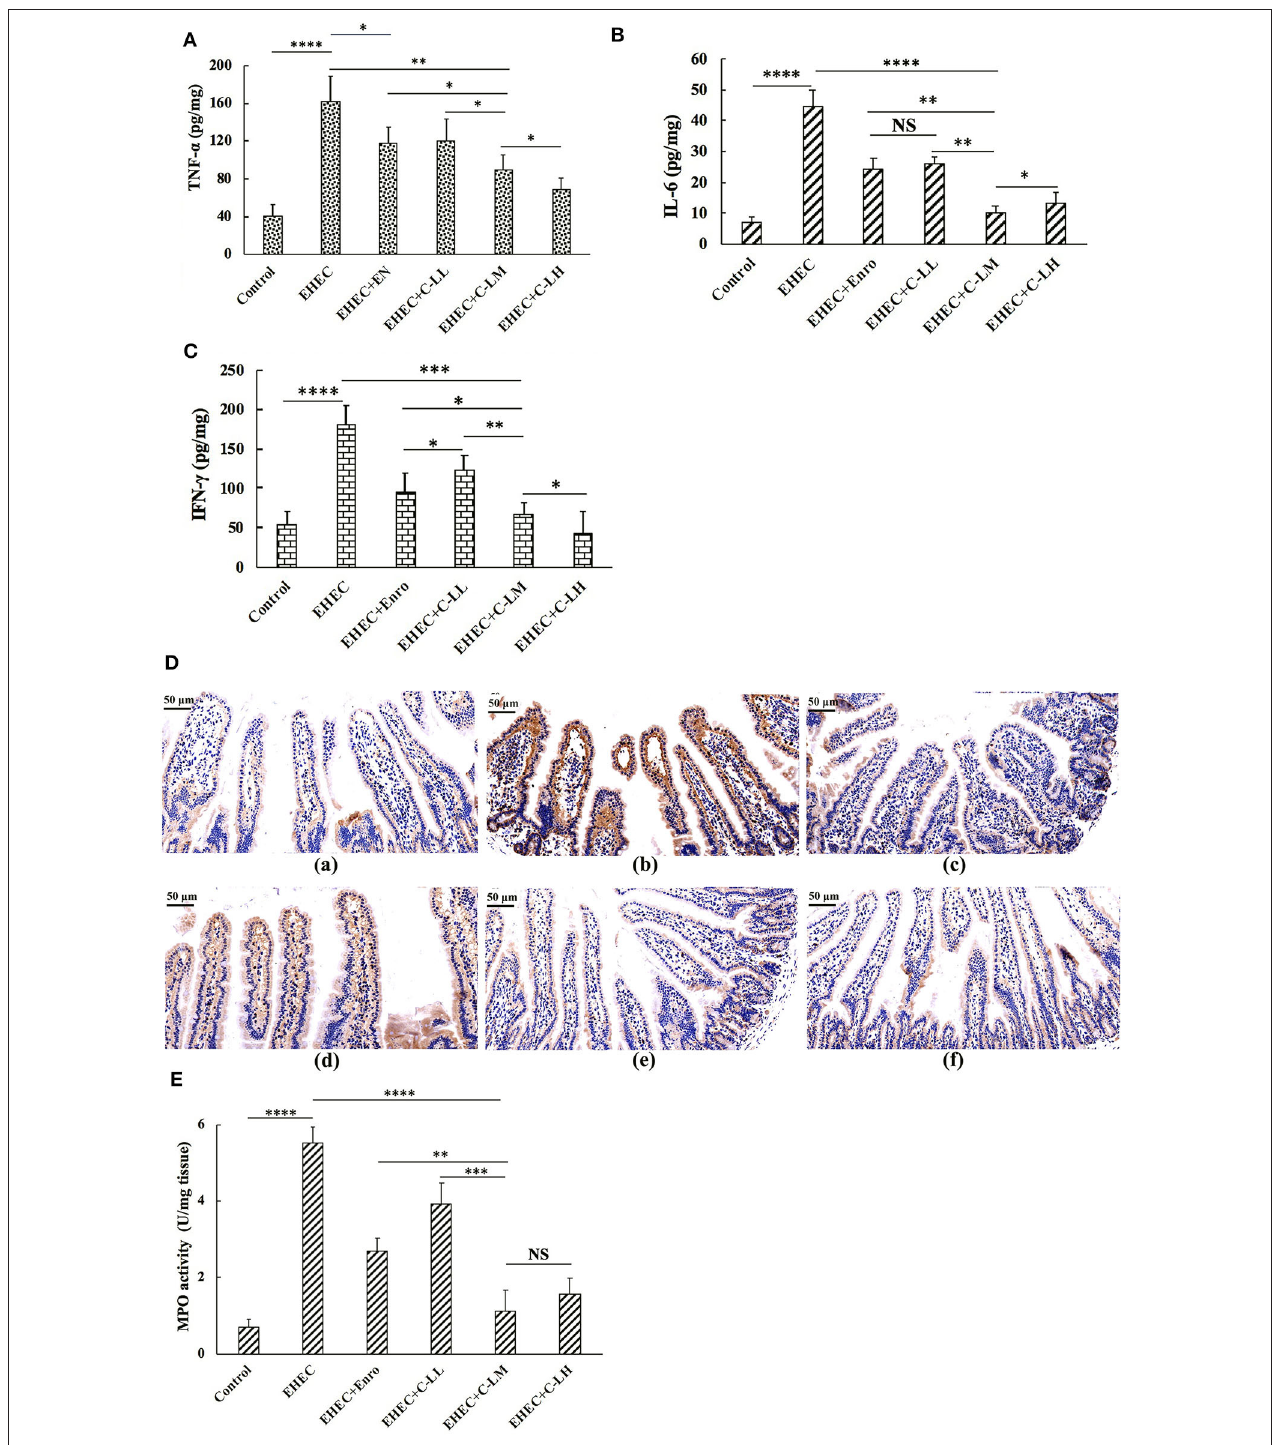
FIGURE 4 | The protective effects of C-L on inflammatory response. The expression levels of TNF- α (A) , IL-6 (B) , and IFN- γ (C) in mouse jejunum tissues were measured by ELISA. (D) Representative images of CD177 + cells in the ( D -a) control, ( D -b) EHEC, ( D -c) EHEC + Enro, ( D -d) EHEC + C-LL, ( D -e) EHEC + C-LM, and ( D -f) EHEC + C-LH groups. Scale bar, 50 µ m. Enzymatic activities of MPO were measured (E) . The control group was orally administered 100 µ L sterile PBS; the EHEC group was orally administered 100 µ L sterile PBS containing 1 × 10 8 CFUs EHEC O157:H7; the EHEC + Enro group was orally administered 100 µ L sterile PBS containing 1 × 10 8 CFUs EHEC O157:H7 and then treated by i.p. injection with 8 mg/kg Enro once/day for 3 days; the EHEC + C-LL, EHEC + C-LM, and EHEC + C-LH groups were administered 100 µ L sterile PBS containing 1 × 10 8 CFUs EHEC O157:H7 and then treated by i.p. injection with 4, 8, and 16 mg/kg C-L, respectively, once/day for 3 days. The data are shown as the mean ± standard deviation ( n = 8). NS, P > 0.05; * P ≤ 0.05; ** P ≤ 0.01; *** P ≤ 0.001; **** P ≤ 0.0001.